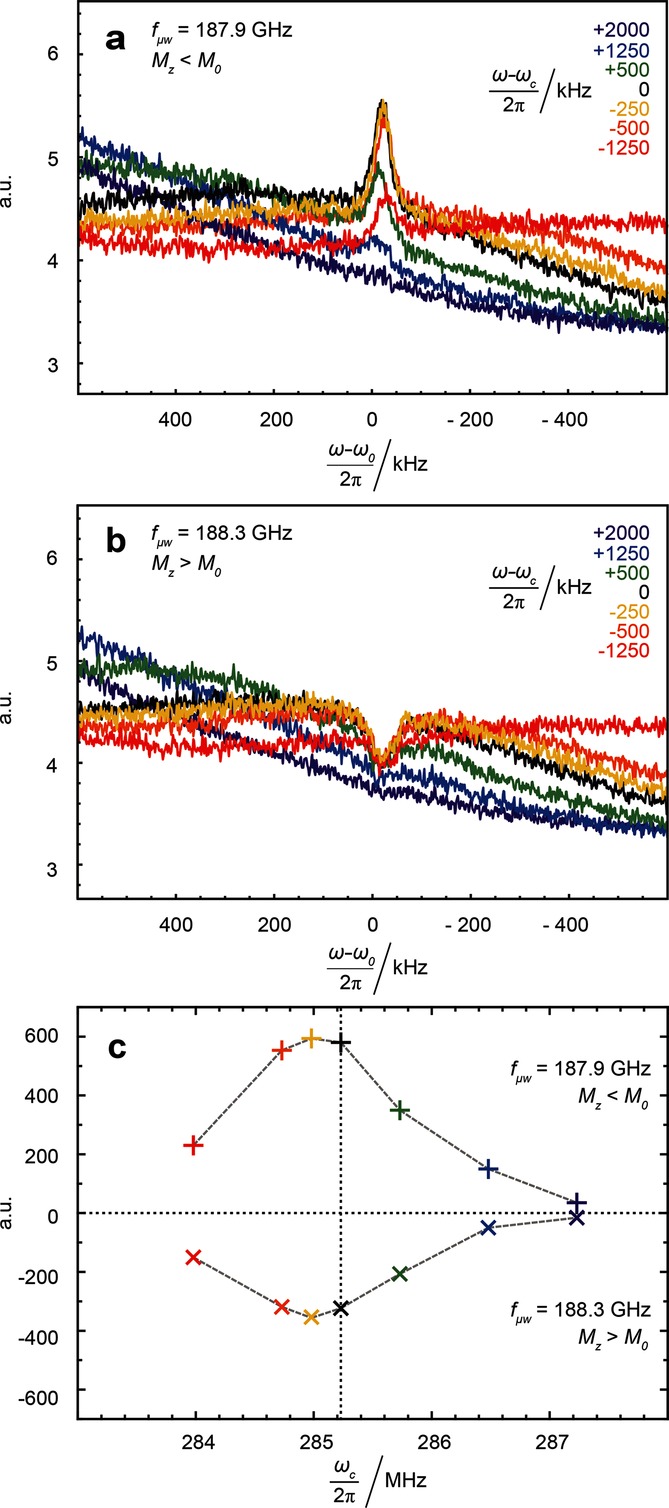
Noise power spectra (a,b) and noise power signal integrals (c) for different rf-tuning positions of the minimum of the wobble curve with respect to the SNTO. Microwave irradiation frequencies: 187.9 GHz (a and upper trace in c) and 188.3 GHz (b and lower trace in c). The colors indicate the corresponding offsets of the tuning frequencies with respect to the Larmor frequency ω0 of the protons at 6.7 T.